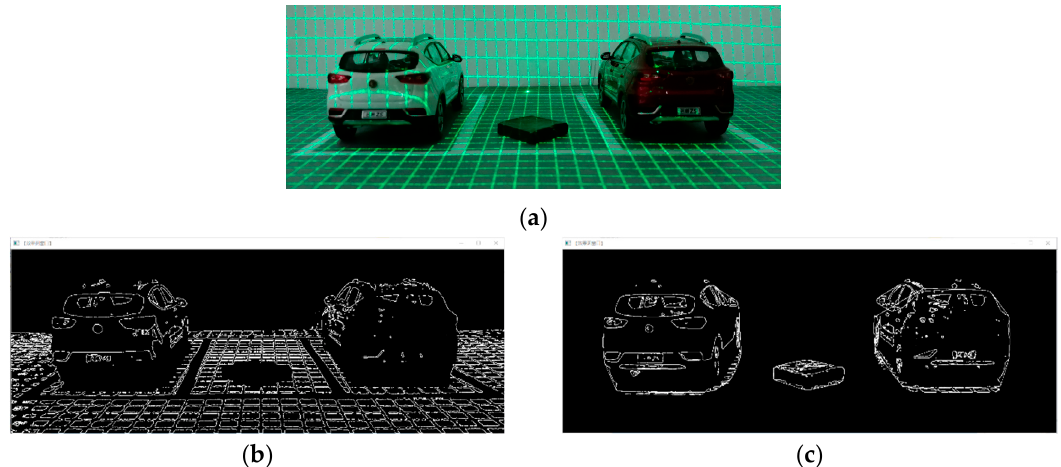
Figure 21. The obstacle exists in the parking space. ( a ) The image of the parking space; ( b ) the contour of the laser grid; ( c ) the contour of cars and the obstacle.